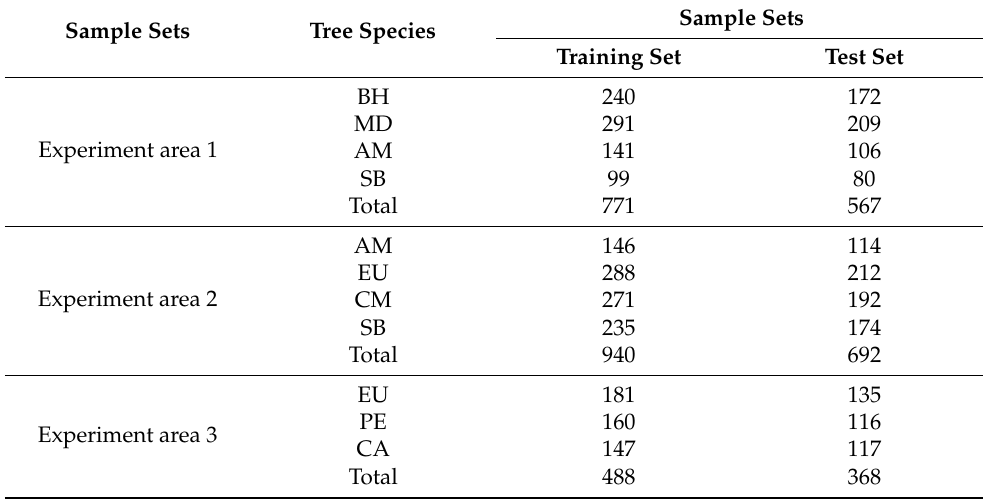
Table 2. The number of trees labeled in all image tiles of training set and test set for each species. Sample